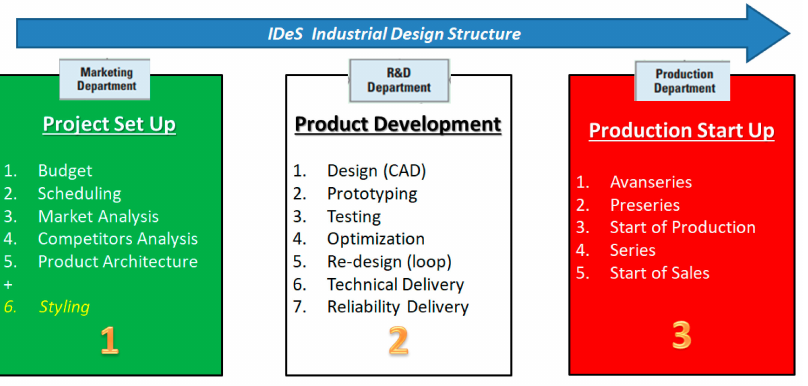
Figure 27. Daft’s idea of company organization matching aspects of IDeS.